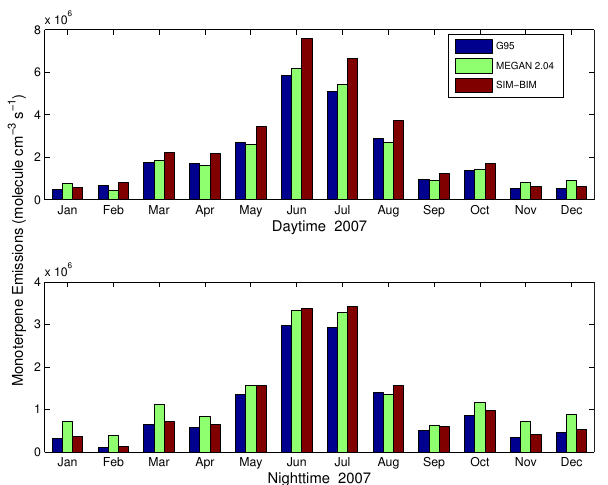
Figure 5. Modelled (G95, MEGAN 2.04, SIM–BIM) monthly aver- ages of daytime and nighttime monoterpene emissions in the canopy at 14m height.